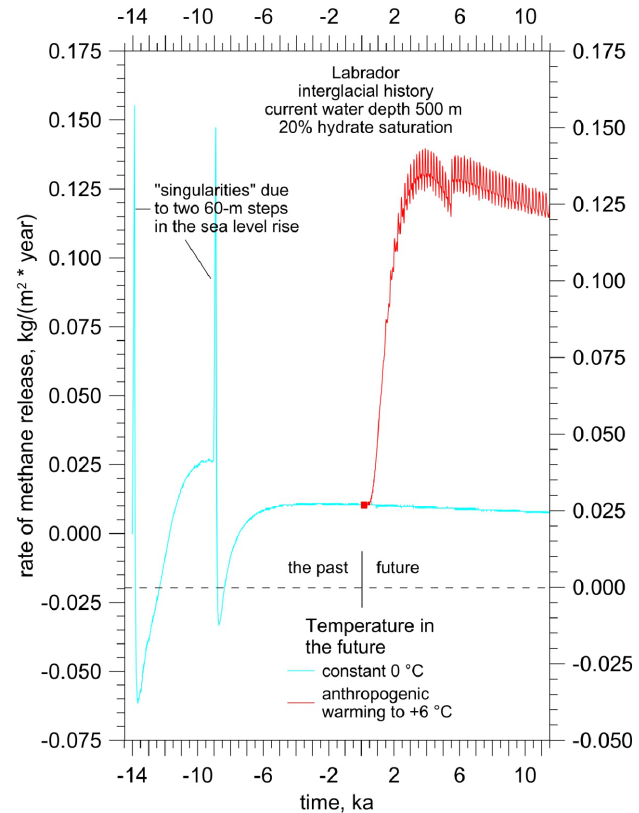
Figure 13. Model methane release rate (kg m − 2 yr − 1 ) history for the Labrador Sea for a current 500 m water